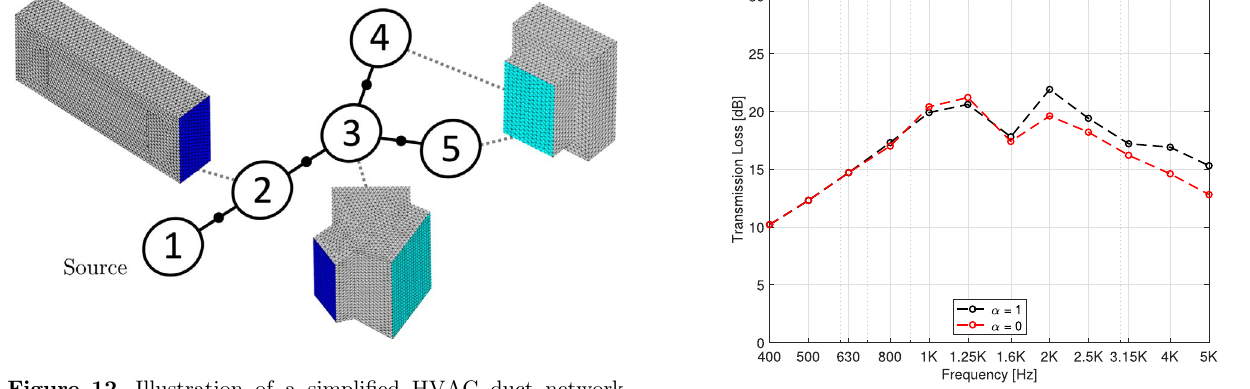
Figure 13. Transmission loss of the HVAC duct network.